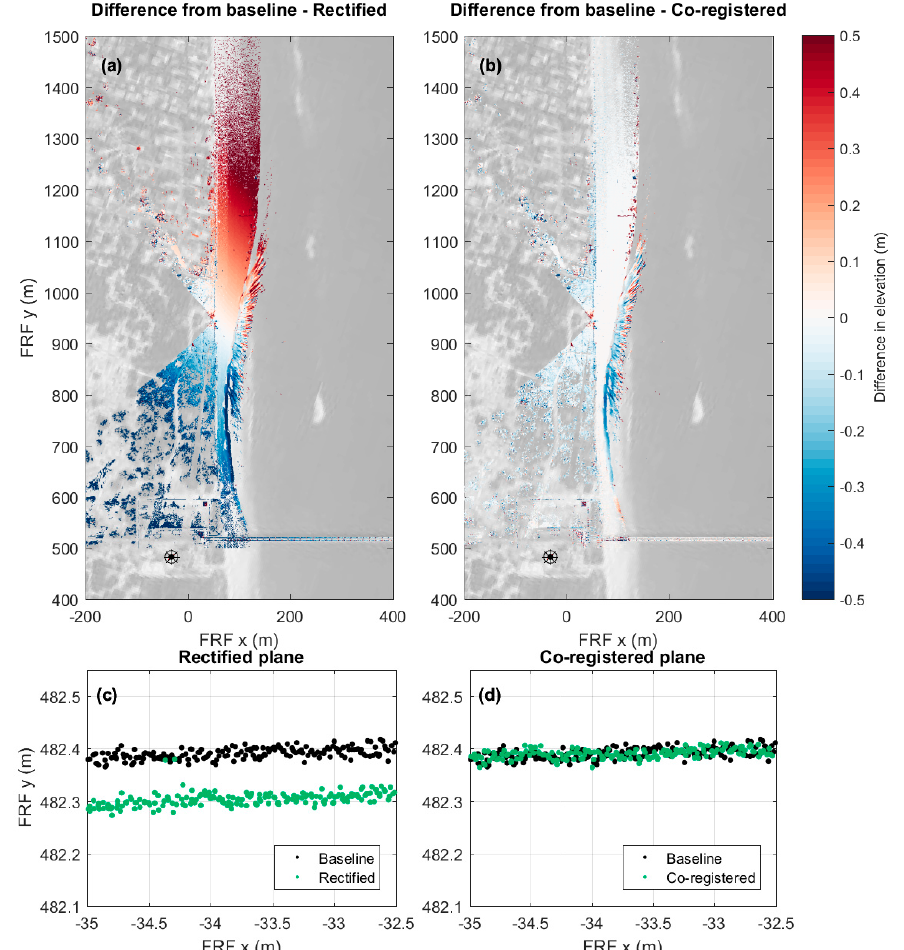
Figure 4. The difference in elevation between the baseline framescan and the ( a ) rectified framescan and ( b ) co-registered framescan from 26 July 2017 17:00 UTC, along with the points on an error assessment plane in the baseline framescan and the ( c ) rectified framescan and ( d ) co-registered framescan from the same time. The location of the error assessment plane is shown with a black star.